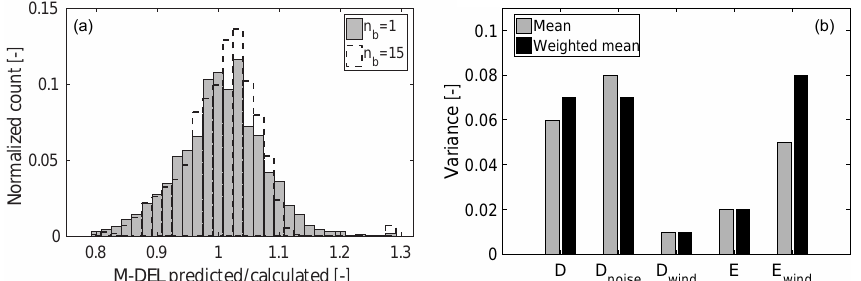
Figure 5. (a) Histogram of DEL ratios for the case “design basis” with 1 and 15 neighbors. (b) Variance of M-DEL ratios for all five test cases using 15 neighbors. The test cases are design basis D , design with artificial measurement noise D noise , design basis with wind speed binning D wind , extended simulations E , and extended simulations with wind speed binning E wind . The neighbors are taken as mean (grey) or weighted mean (black).